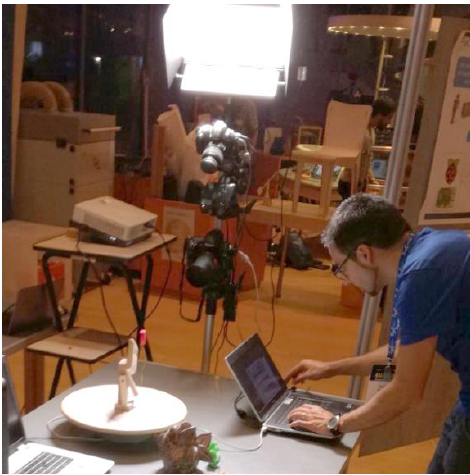
Figure 3. A vertical setup with the two cameras realized for a demo during the 2017 European Researchers' Night.